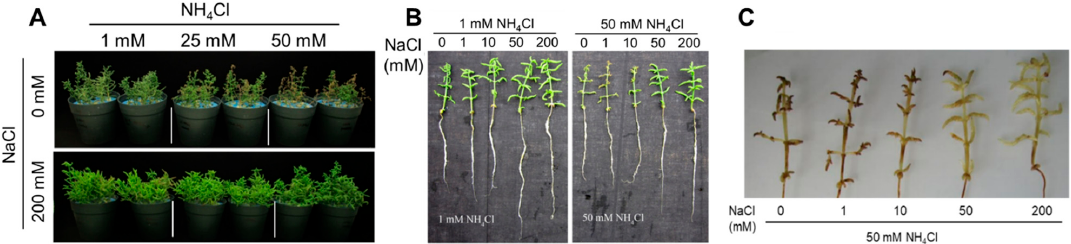
Figure 2. ( A ) S. europaea phenotype as affected by two concentrations of NaCl in combination with three concentrations of NH 4 Cl. ( B ) Whole seedlings of S. europaea under NaCl/NH 4 Cl treatments. ( C ) Detection of peroxides using DAB staining on S. europaea under 50 mM NH 4 Cl and increasing concentrations of NaCl.